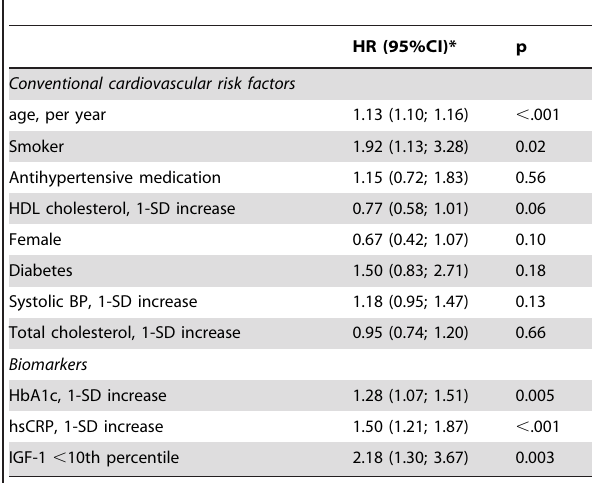
Table 4. Prediction of cardiovascular death by backward-